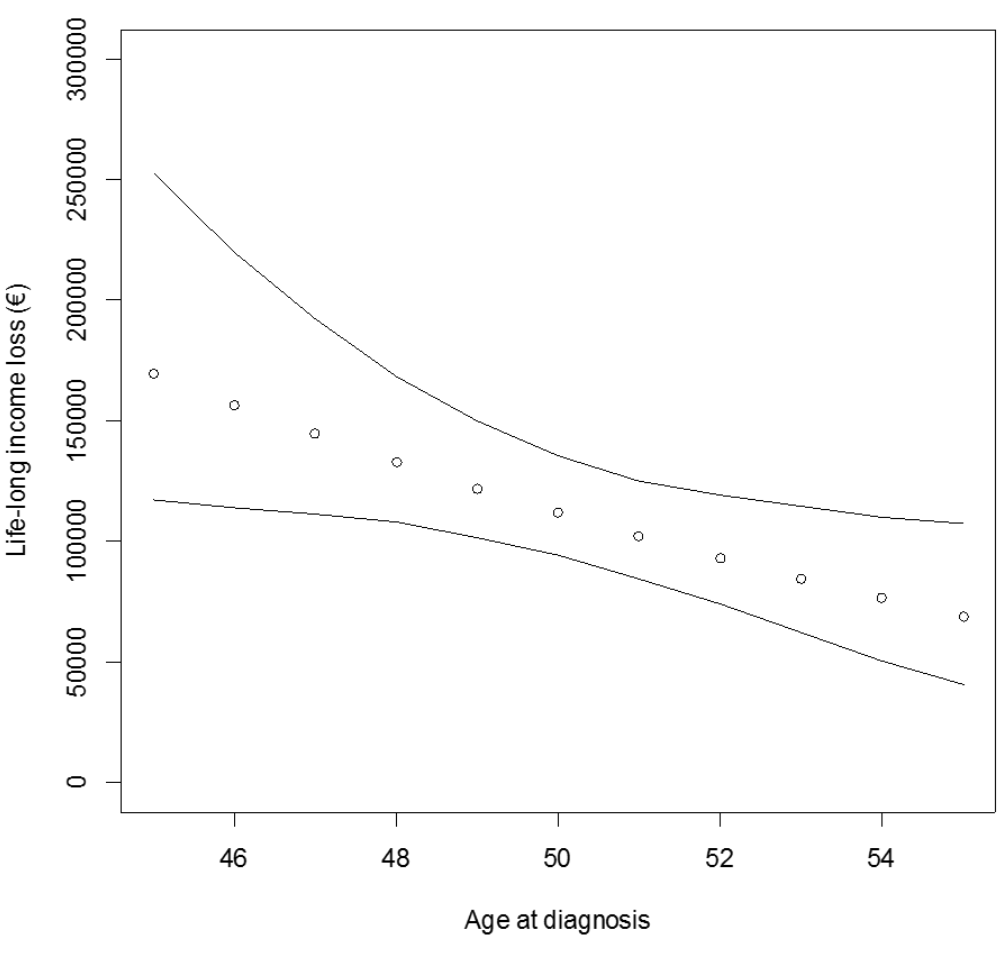
Figure 4: Estimated life-long income loss as a function of age at